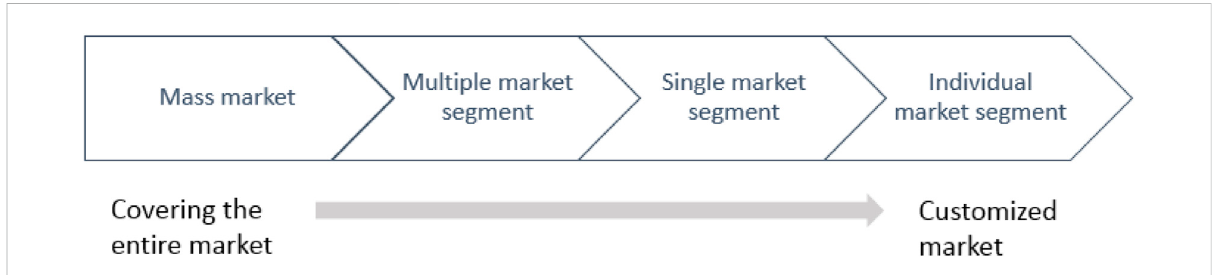
FIGURE 2 Segment market classi fi cation.